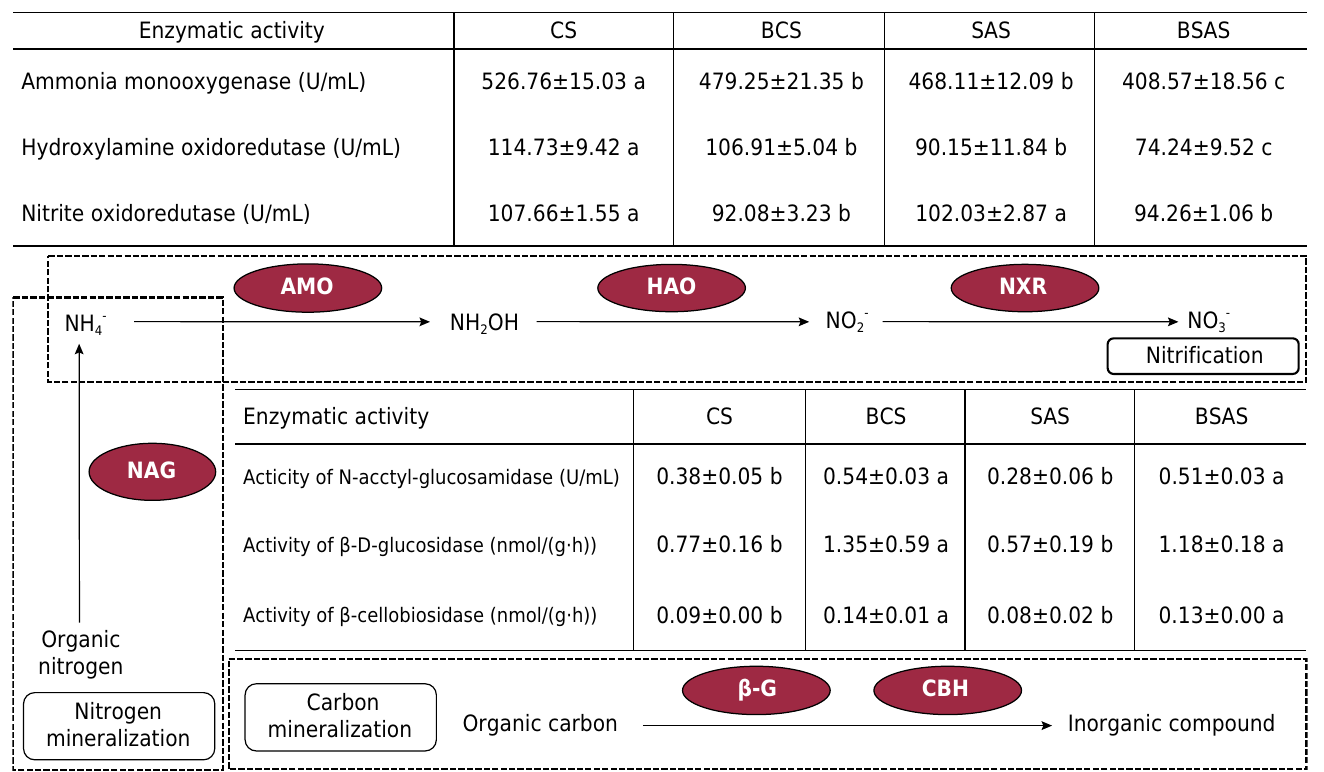
Nitrogen Figure 1. Activity of C and N cycle-related enzymes of soil in biochar application. Different letters indicate significant differences among treatments (p<0.05).